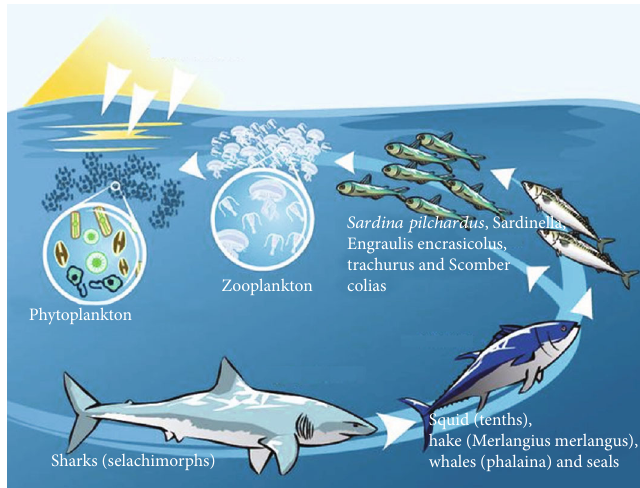
Figure 1: The pyramid of the marine food